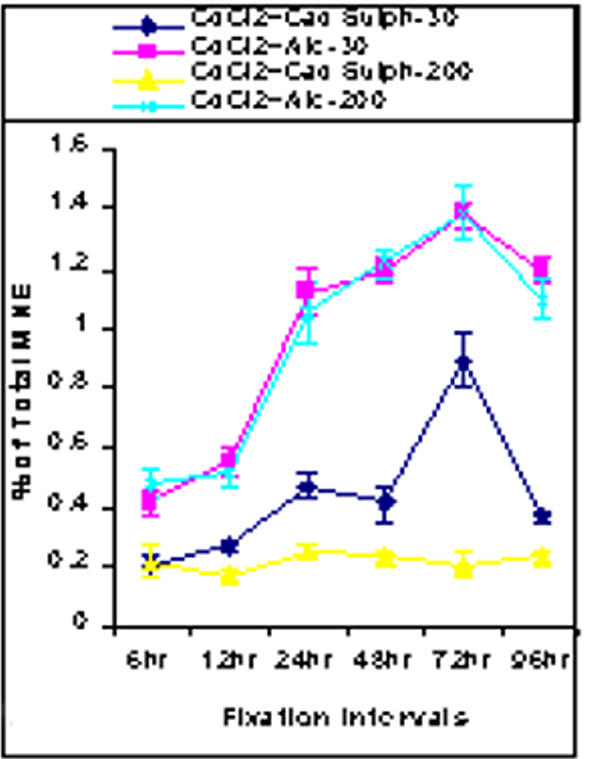
Figure 13 Showing time-dependent frequencies of Cad Sulph-30 com- bined pre- and post- fed and Cad Sulph-200 combined pre- and post-fed series versus their respective CdCl 2 treated alcohol-30 and alcohol-200 control mice. Chromosome aberration (CA)-9; Mitotic index (MI)-10; Micronucleated erythrocytes (MNE)-11 and Sperm head anomaly